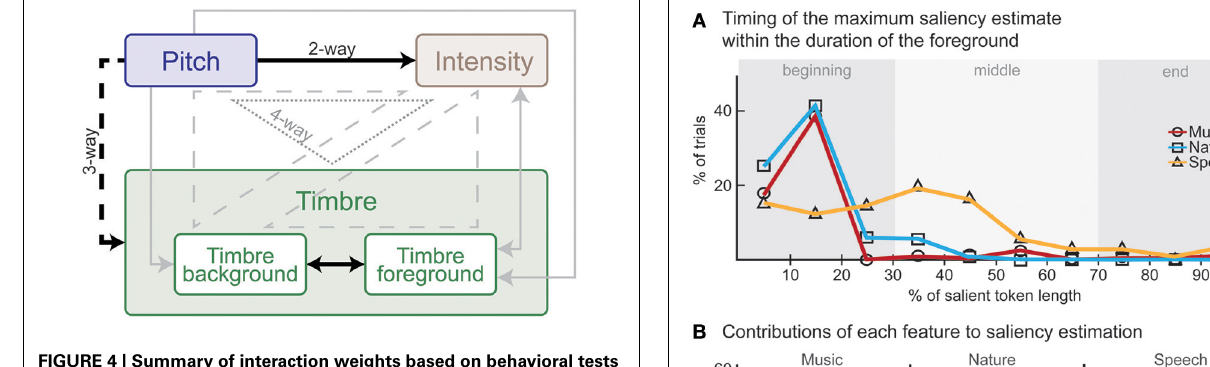
FIGURE 4 | Summary of interaction weights based on behavioral tests with human listeners. Solid lines indicate two-way, dashed lines three-way and dotted lines four-way interactions. Effects that emerged in every experiment are shown black, and those that were found in at least one experiment are shown gray. Arrow directions indicate direction of interaction: the origin feature has a relatively larger effect on the destination feature in all experiments. Double-sided arrows indicate that there is no clear weight either way. The weight and directionality of interactions observed are inferred from the coefficients of the fitted model, and are limited by the levels of sound features tested in this study.